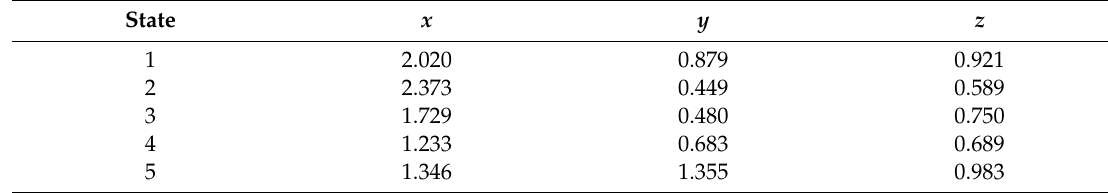
Table 5. RMSE of wing deformation measurement